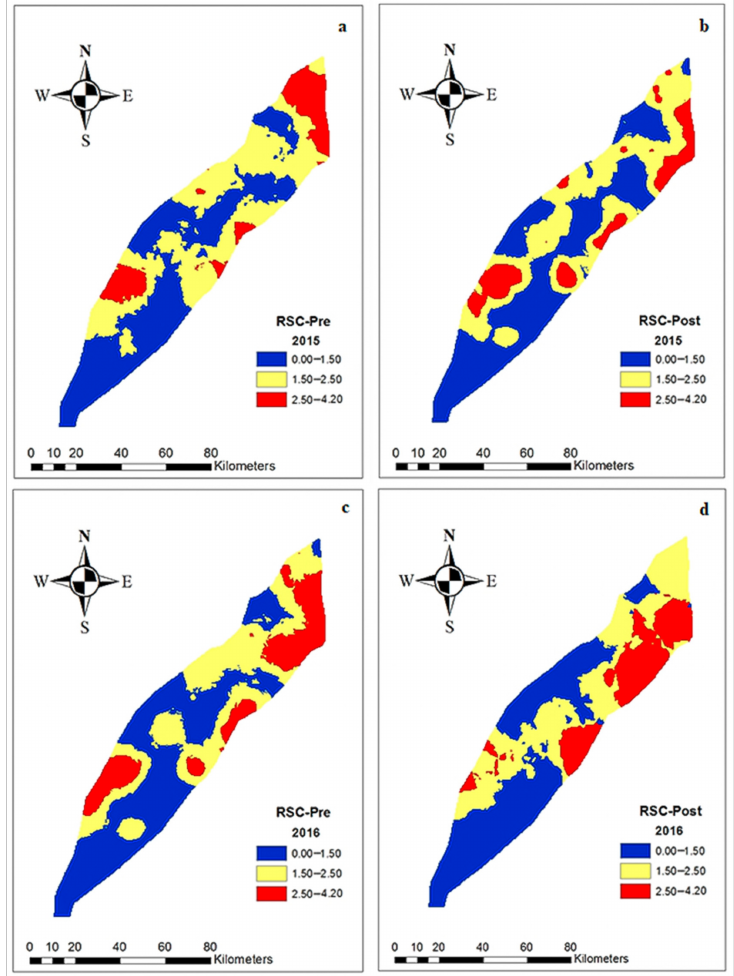
Figure 4. Spatial distribution of groundwater RSC (meql / l) ( a ) for pre-monsoon season in 2015 ( b ) for post-monsoon season in 2015 ( c ) for pre-monsoon season in 2016 ( d ) for pre-monsoon season in 2016.